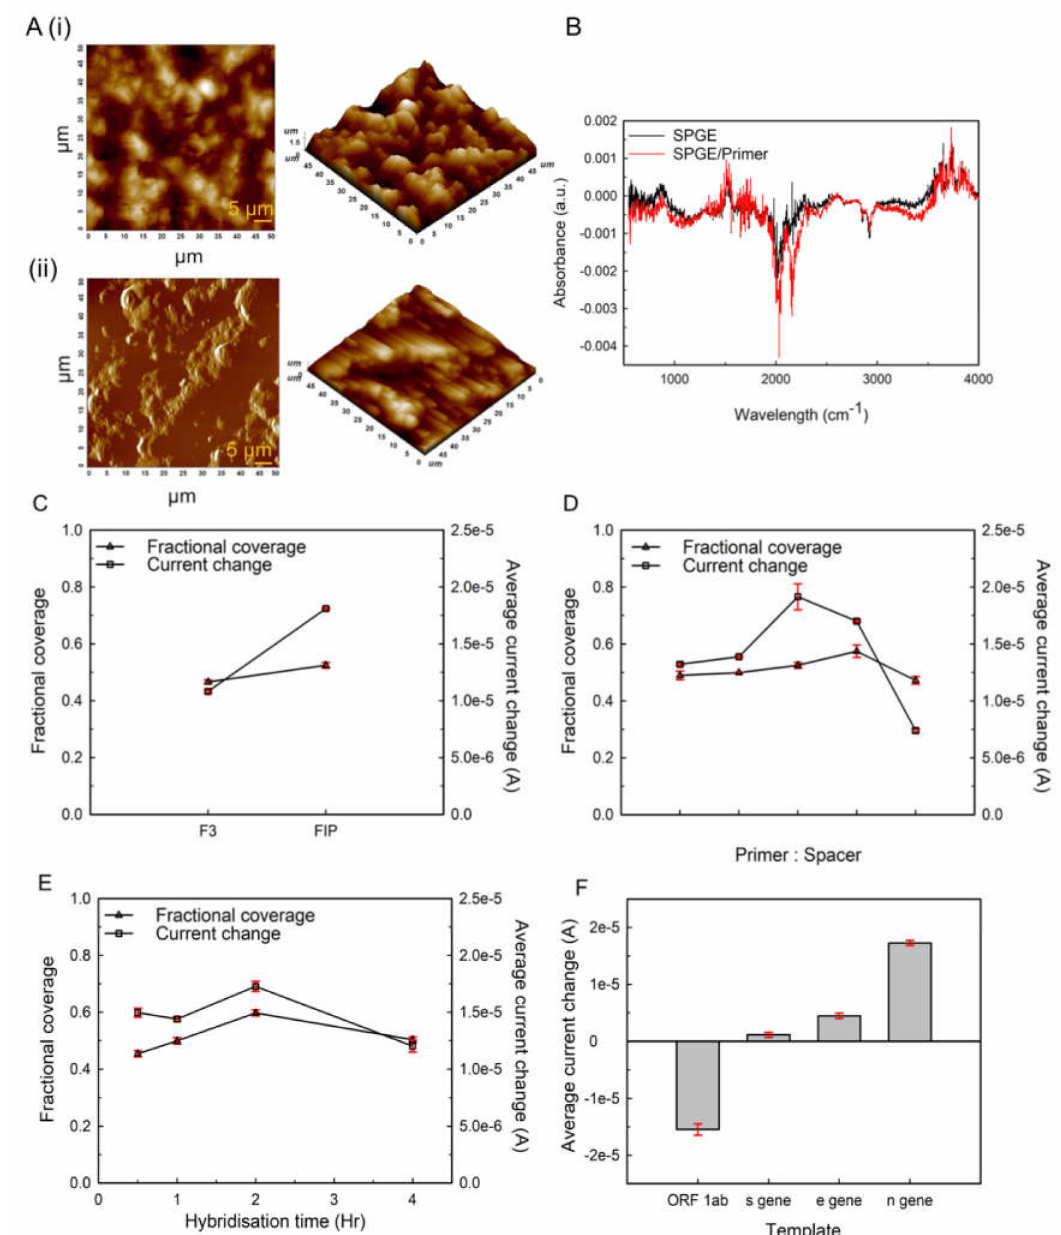
Figure 4. Surface characterization of SPGE-based electrochemical sensor for SARS-CoV-2; ( A ) To- pographical scan in height mode at a scale of 5 µ m of ( i ) unmodified, ( ii ) modified SPGE/ β - ME/ssDNA probe. ( B ) FTIR spectra of unmodified and modified SPGE/ β -ME/ssDNA probe. ( C ) Selection of appropriate primer (F3 and FIP) for target gene (N-gene). ( D ) Optimization of ratio of primer to spacer for development of Self-assembled Monolayer (SAM). ( E ) Selection of optimum time-point for hybridization of primer with target gene. ( F ) Establishment of response against non-specific